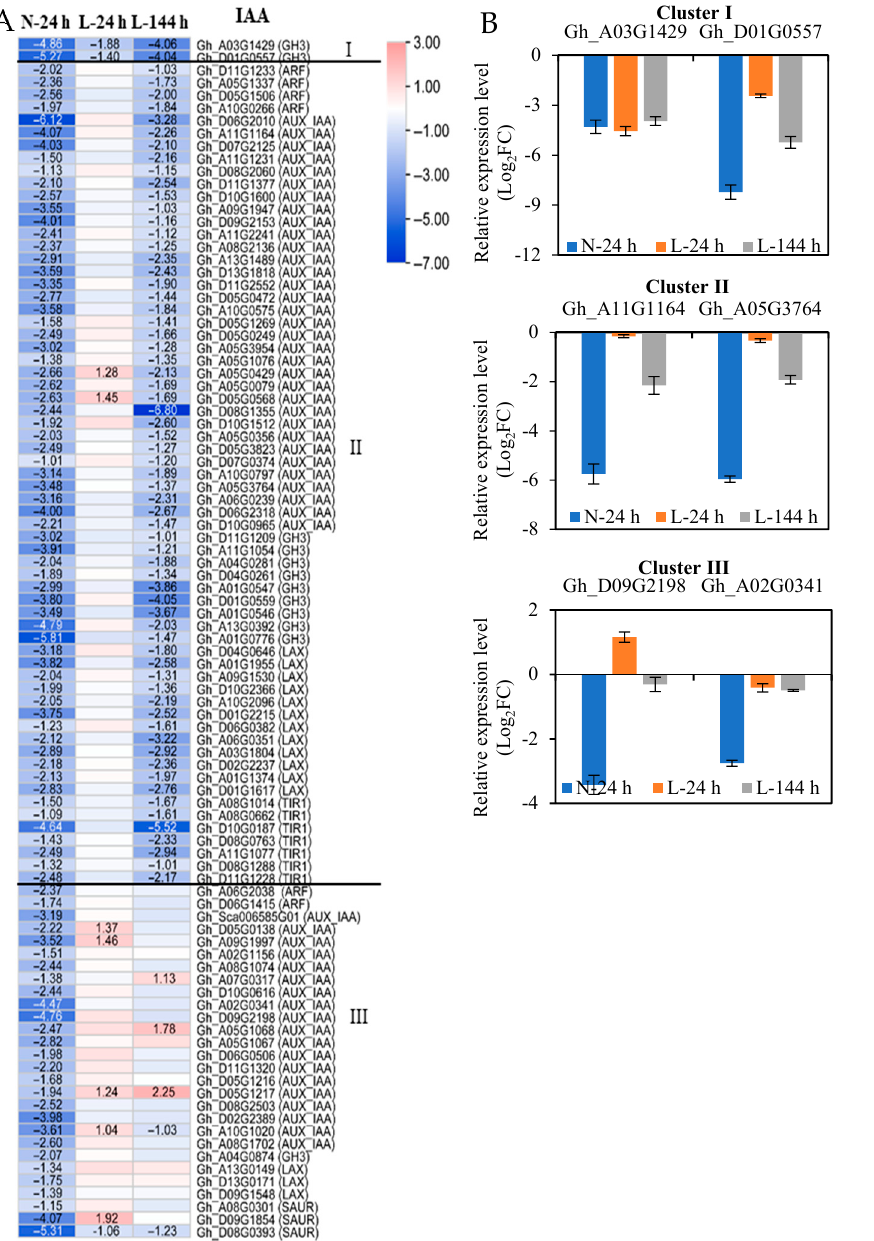
Figure 3. The expression of IAA-signaling genes in AZs treated with TDZ at different temperatures. ( A ) The heatmap is generated based on the RNA-seq data. The number in the box indicates the fold-change expression of the gene (only those with a ≥ one-fold difference are shown). TDZ-induced downregulated and upregulated expressions are indicated by blue and red colors, respectively. I, II, and III represent three types, respectively. All the numbers in the heatmap represent fold changes; ( B ) the expression levels of selected genes from real-time quantitative PCR (RT-qPCR). The Y -axis indicates log 2 FC values. Data represent the means ± SD of three biological replicates, and each biological replicate contains three technical replicates. The same as below.